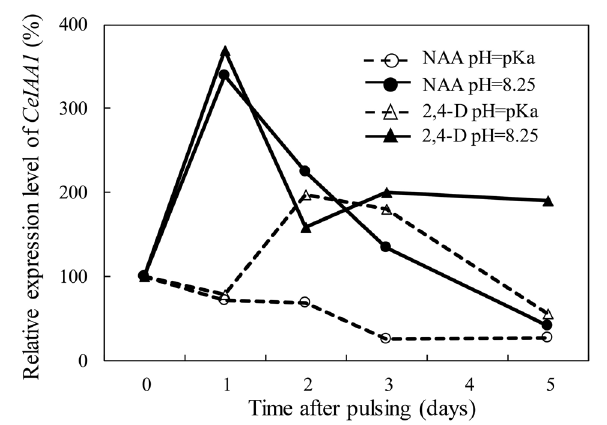
FIGURE 5 | Effect of the pH of the pulsing solution on the influence of NAA and 2,4-D on the transcript level of CeIAA1 gene in the floret AZ of Red Cestrum cut flowers during vase life. The cut flowers were pulsed for 4 h at 20 ◦ C and for additional 20 h at 4 ◦ C with 0.2 mM NAA or 2,4-D at pH = pKa or at pH = 8.25, and then placed in TOG-6 solution for further incubation under vase life conditions at 20 ◦ C. The qRT-PCR analysis was performed with RNA extracted from 2- to 3-mm-long floret AZ sections, excised at the indicated time points after pulsing during vase life. The expression level of CeIAA1 was calculated relative to its basal level at the end of pulsing (0 time). The pKa values of NAA and 2,4-D are 4.23 and 2.75, respectively. The results represent average values of four biological replicates (two replicates of qRT-PCR reactions in each one of the two separate experiments performed).